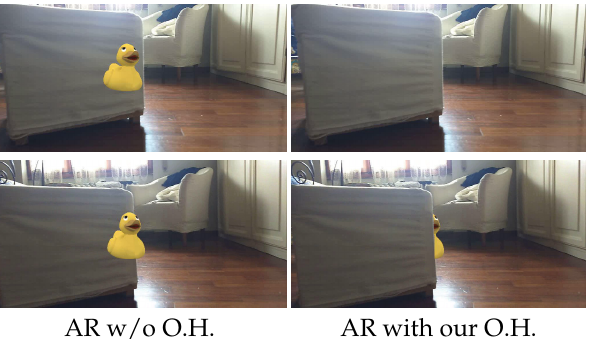
Figure 9. AR with occlusion handling. On the left, vanilla AR enabled by an Android device with ARCore. On the right, instead, our depth-aware AR enabled by single image depth prediction with PyDNet for occlusion